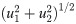
3-Spike burst ISI patterns encode the phase and amplitude of oscillatory components.(A–C) Analysis of the cell shown in Fig 1. (A) Stimulus sequences preceding 3-spike bursts with different burst phases. Bursts were divided into 12 groups according to the burst phase (bin size = 30°). Stimulus sequences preceding the bursts in each group were averaged and are shown in each row. (B) Average stimulus sequence preceding 3-spike bursts (3-BTA). (C) Deviation from 3-BTA calculated by subtracting the 3-BTA shown in (B) from the preceding sequences shown in (A). (D–F) Population analyses. (D) Same analysis as in (C), averaged among 19 cells that generated at least 1200 3-spike bursts. (E) Thick lines indicate data in (D) at the indicated burst phase. Thin lines indicate the SEM values calculated across the cells. Peaks around −100 ms are indicated. (F) Horizontal axis: (u12+u22)1/2, i.e., the distance of the point (u1,u2) from the origin in the u1–u2 plane in Fig 4E. Vertical axis: the root mean square of the oscillatory components between −200 and 25 ms. The error bars indicate SEM values for the 19 cells.